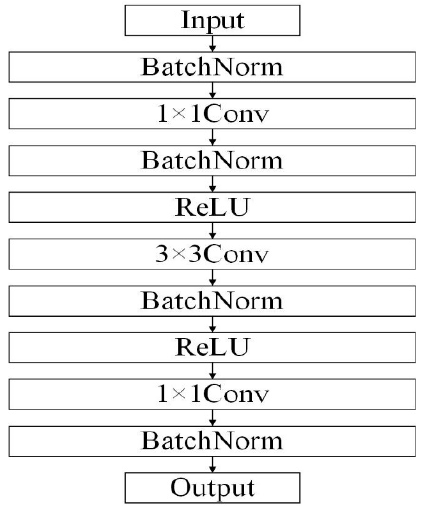
Figure 7. The improved Dense